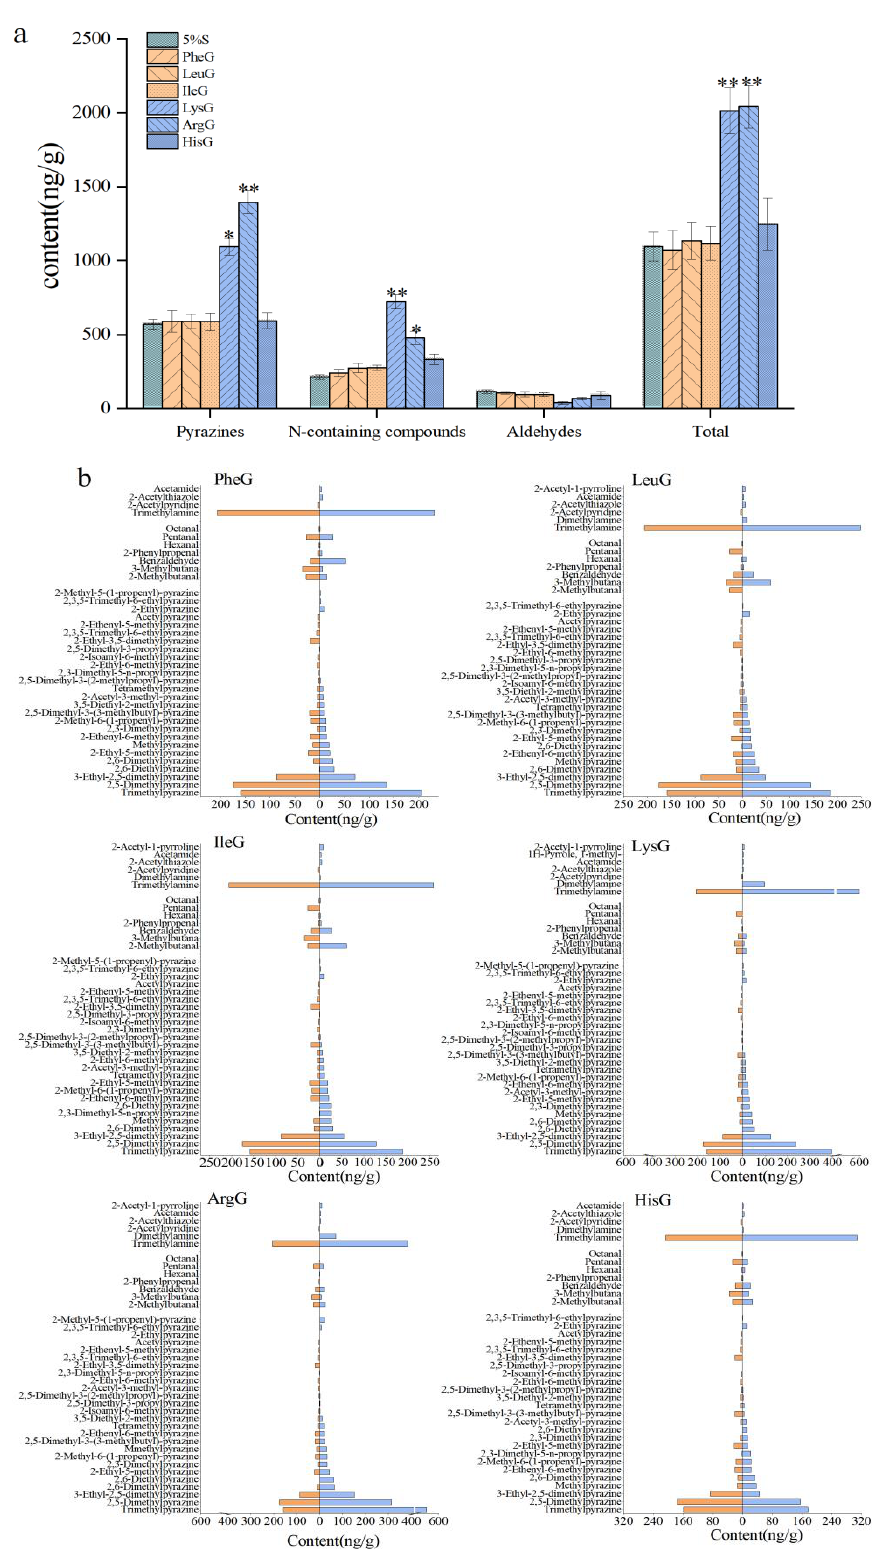
Figure 4. Contents of volatile components of different classes in shrimp before and after adding amino acids ( a ) (** indicates significant difference compared to 5%S ( p ≤ 0.01); * indicates significant difference compared to 5%S ( p ≤ 0.05)) and comparison of different pyrazines, N-containing com- pounds and aldehydes in shrimp before and after adding amino acids ( b ) ( The volatile com- pounds in 5%S; The volatile compounds in shrimps after adding amino acids).